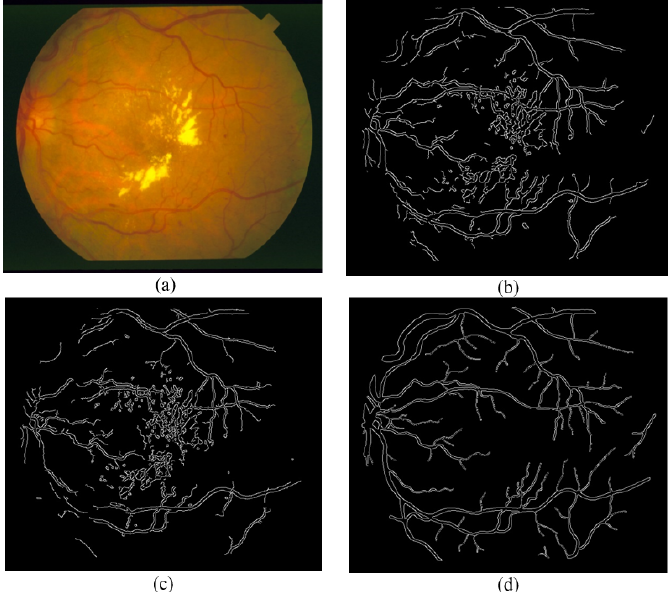
Figure 19. Comparison of segmented images for image 0001 from STARE dataset. ( a ) Input image. ( b ) Segmented image using the proposed approach (GUI based) (the obtained PFOM value is 0.5208). ( c ) Segmented image using Canny detector with ideal parameters (i.e., low threshold is set at 10, and high threshold is set at 32) (the obtained PFOM value is 0.4346). ( d ) Ground truth image from STARE